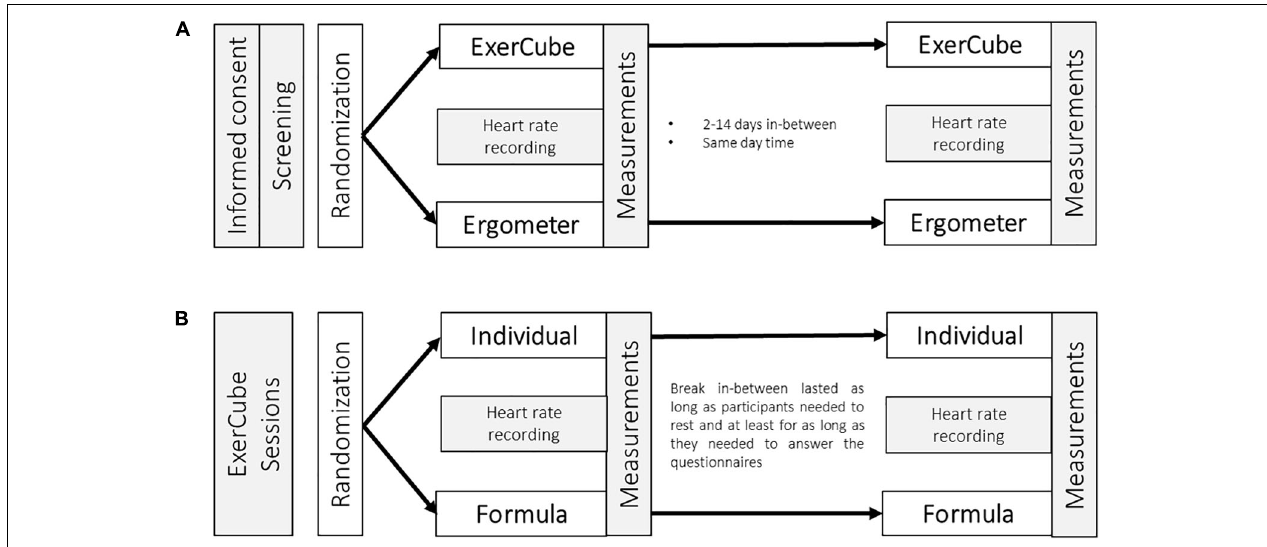
FIGURE 2 | Study procedure. (A) Testing sessions to assess individual maximal heart rate. (B) Comparison of in-exergame adaptation. In-between (A) and (B) are 2–14